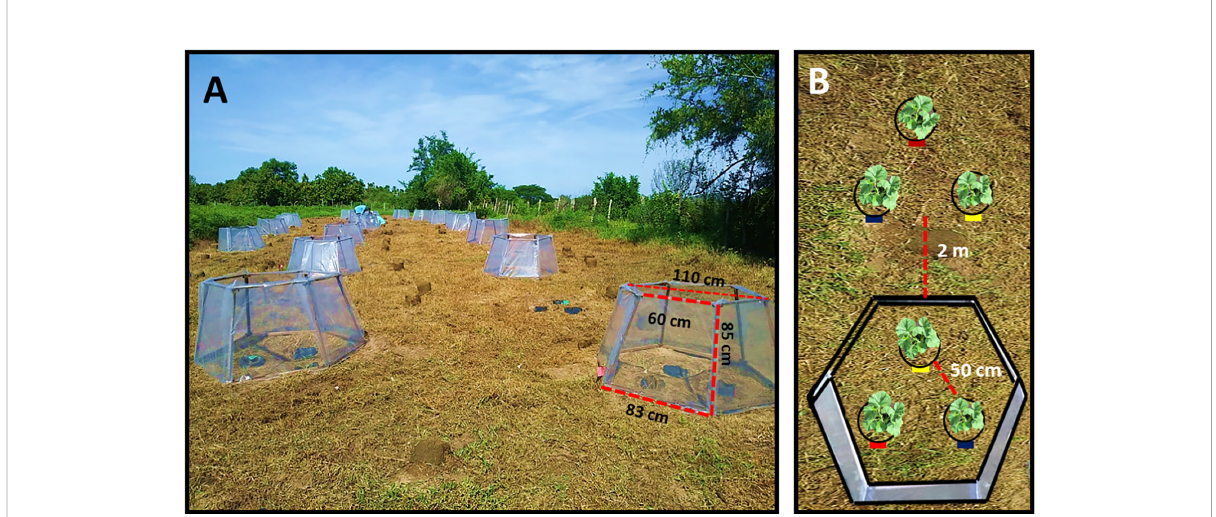
FIGURE 1 Field site showing (A) dimensions of OTCs where plants at increased temperature were placed and location of plants at ambient temperature (green oval), and (B) location of plants without fertilizer (yellow), with organic (red) and synthetic (blue) fertilizers inside and outside